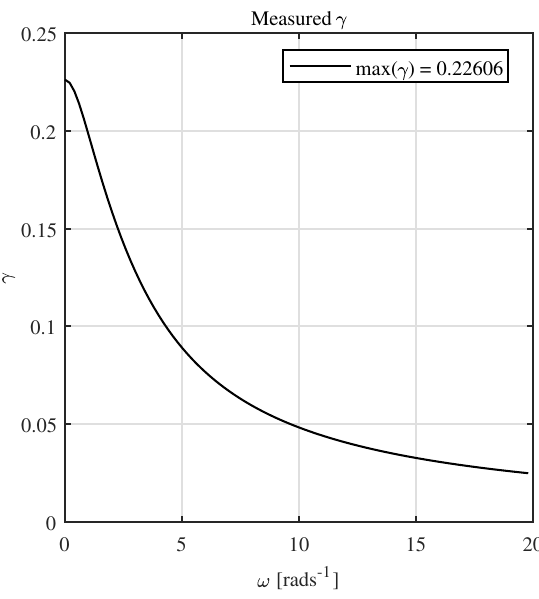
Figure 8: Time response of the controlled output variable.